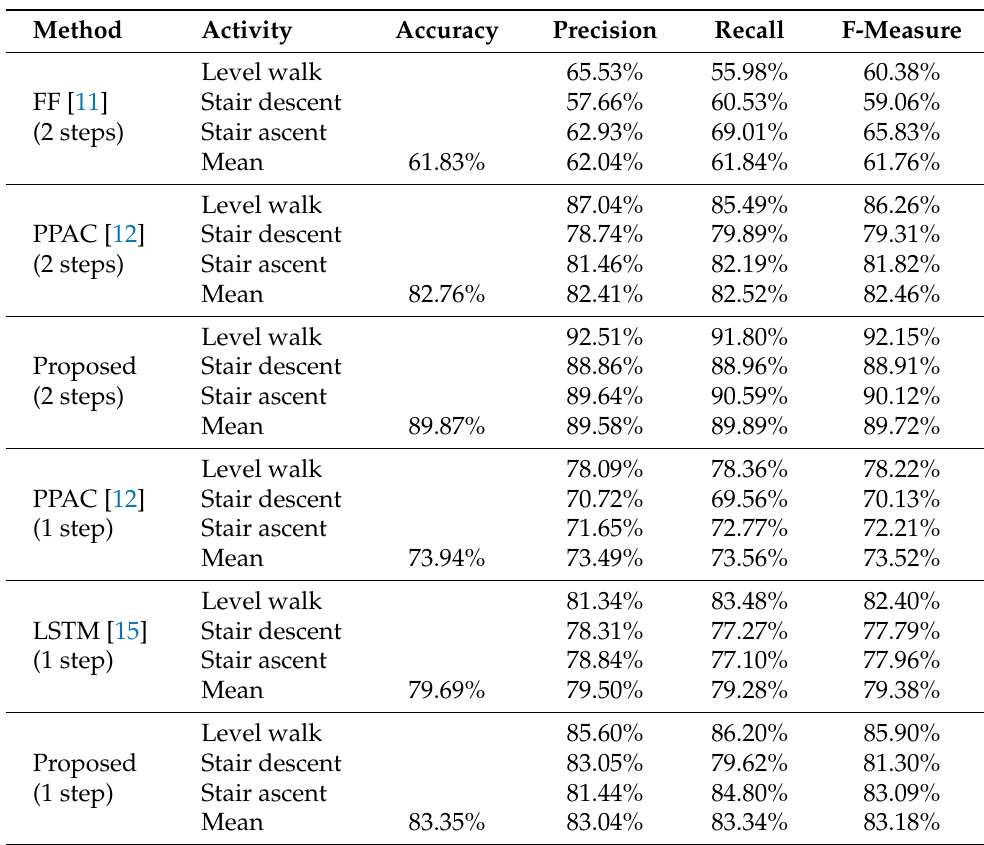
Table 3. Performance in each activity.